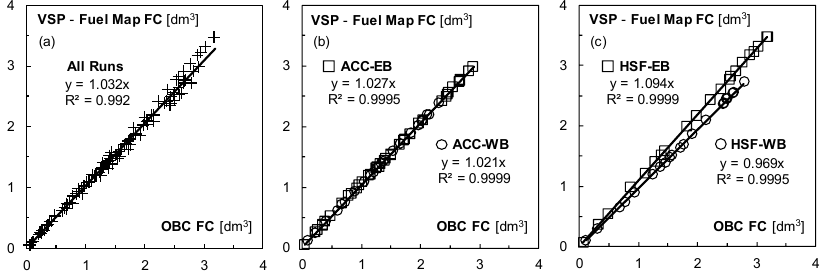
Figure 8. Parity lines between onboard computer (OBC) fuel consumption readings and results computed from the engine fuel map combined and road vehicle specific power (VSP) load.